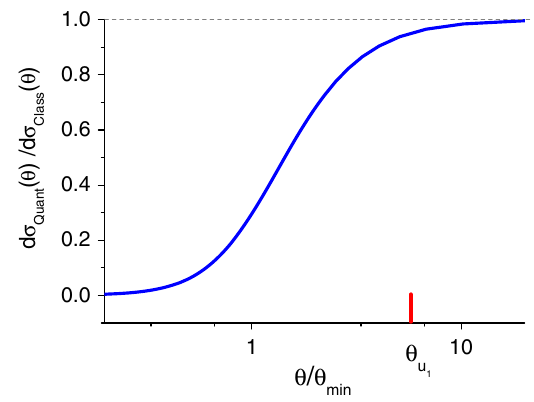
FIG. 2. The ratio of quantum to classical cross sections versus the scattering angle for a Si atom ( α Z ¼ 0 . 102